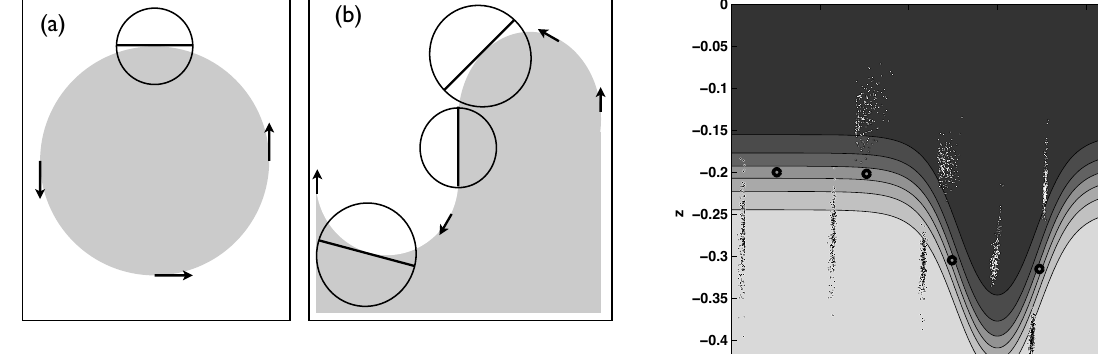
Fig. 3. (a) Diagram of the geometric explanation for the stochastically induced outward drift in a circular vortex. The flow is indicated by arrows. A circle representing the standard deviation of the stochastically perturbed particle is shown with the bisector of the circle formed by the tangent line to the circle. It can be seen that more than one half of the area of the circle lies outside of the grey region. (b) as (a) but for a more complex path with varying curvature.